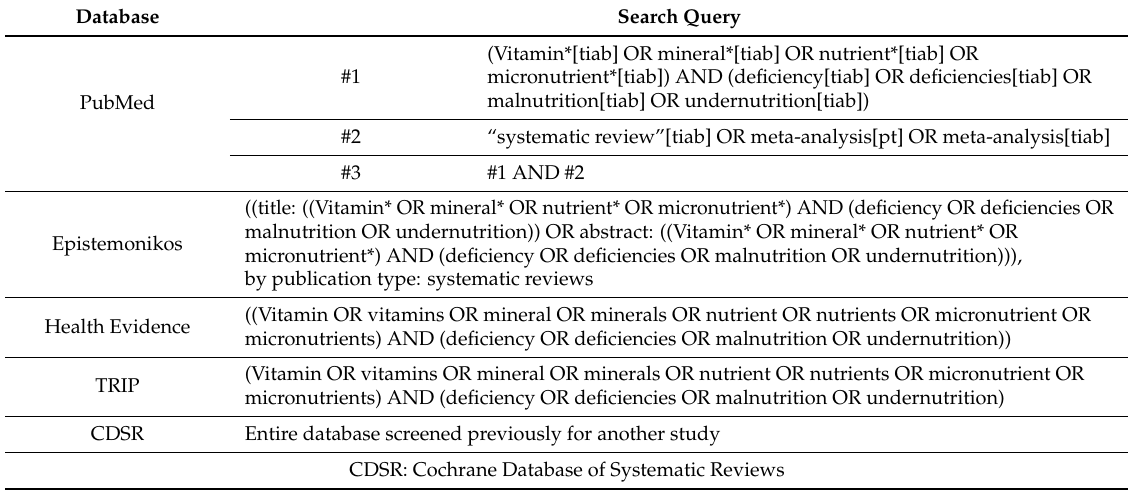
Table 1. Search strategy for systematic reviews and systematic review